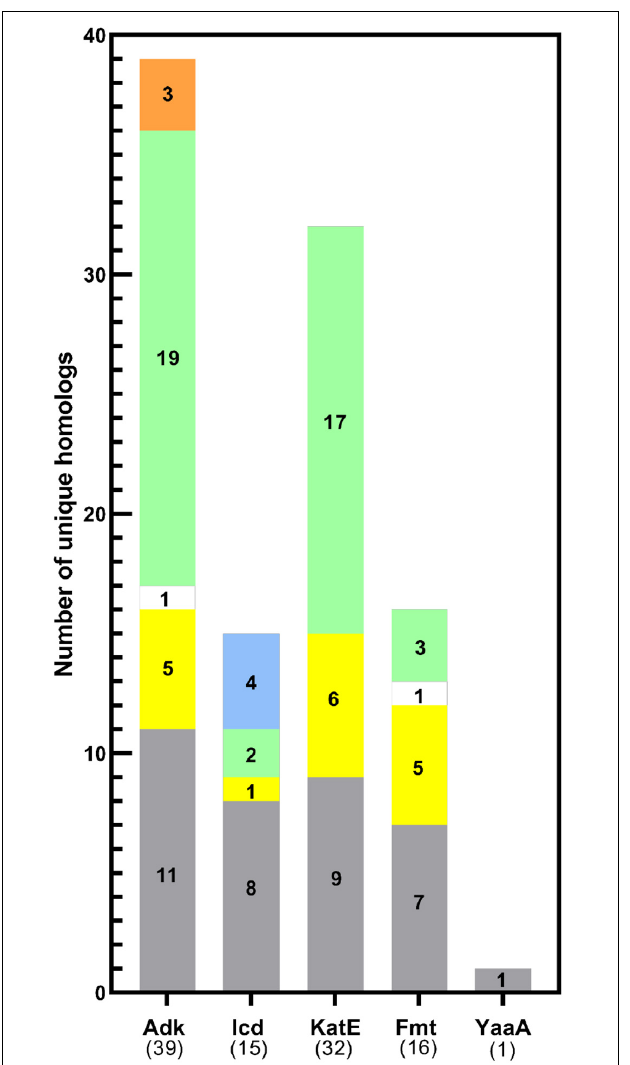
FIGURE 4 | Distribution of KAT substrate protein homolog 3D structures across domains of life. The total number of homologs of each KAT substrate protein with unique UniProt IDs analyzed in this study are shown in parentheses on the x-axis. The target E. coli K-12 strain protein was also included in the total. Bars are colored by domain of life: Gram-negative (gray), Gram-positive (yellow), or Gram-variable (white) Bacteria, Eukaryotes (green), Archaea (blue), and synthetic constructs of ancestral proteins